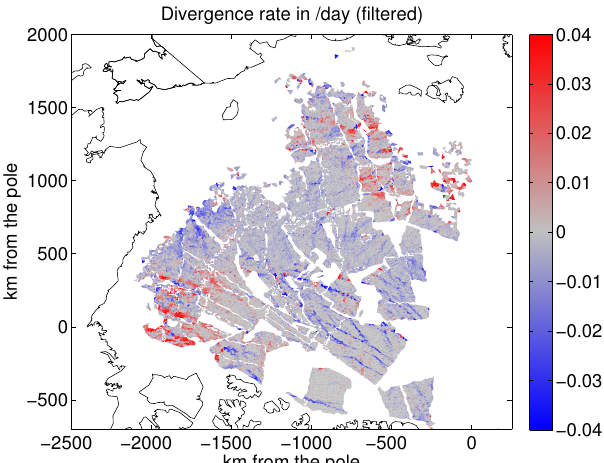
Figure 7. Composite picture of the divergence rate given by the RGPS deformation data set for the period 2–10 February 2007. RGPS cells are here represented by squares as their actual shape is not known.